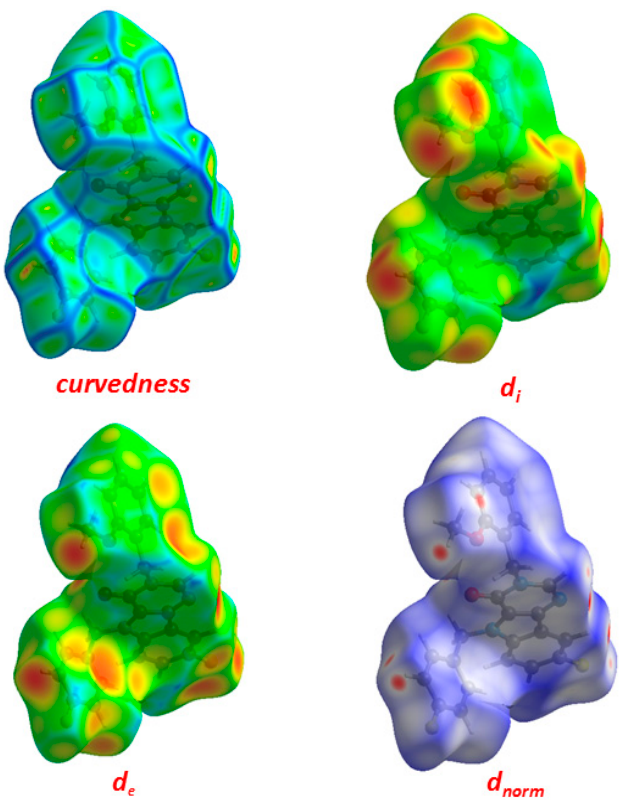
Figure 5. Hirshfeld surfaces for d norm , d i , and d e and curvedness for Compound ( 3 ).